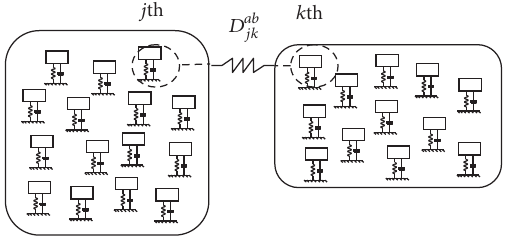
Figure 2: Two sets of oscillators connected via a set of